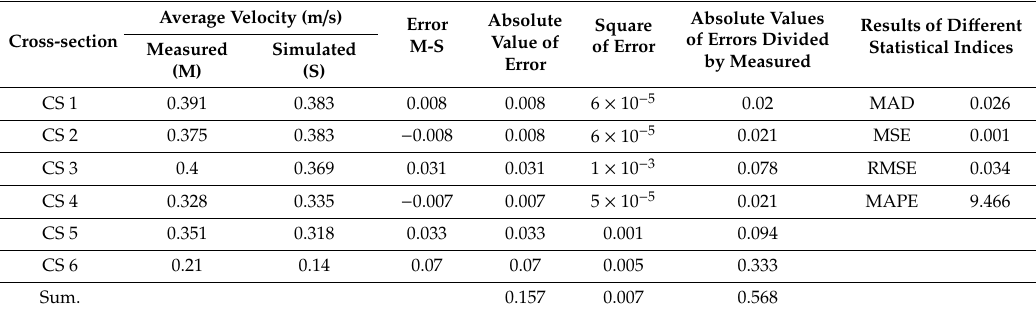
Table 3. Statistical indices for measured and simulated average